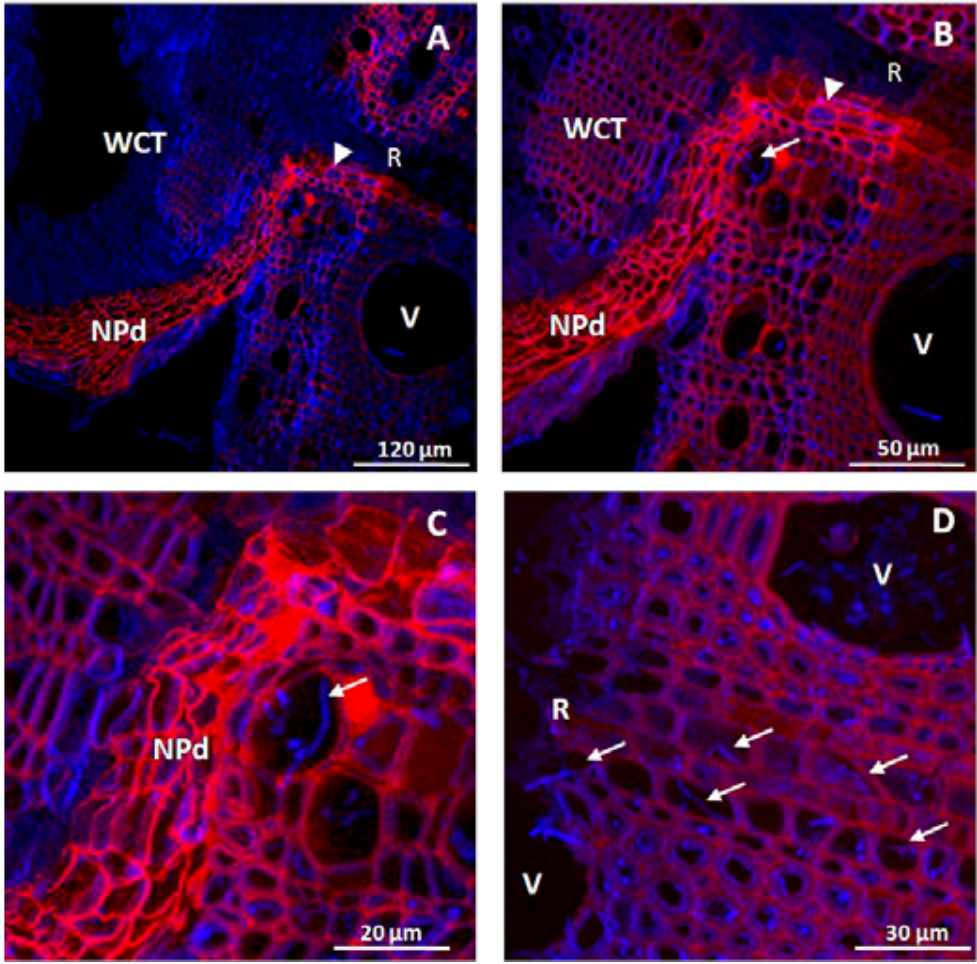
Figure 4. (A–C) Localization of Pch hyphae at junction of necrophylactic periderm and xylem tissue. Layout pictures of confocal micrographs obtained with filter Aand filter B. Arrows indicate fungal hyphae near the junction, and arrow head indicates cell layer bordering the ray. (D) Close view of infected xylem. Arrows indicate hyphae progressing in a ray. Note the continuity of hypha in the vessel close to the ray in the bottom-right corner. The notation NPd stands for necrophylactic periderm, R is for ray, V is for vessel, and WCT is for wound closure